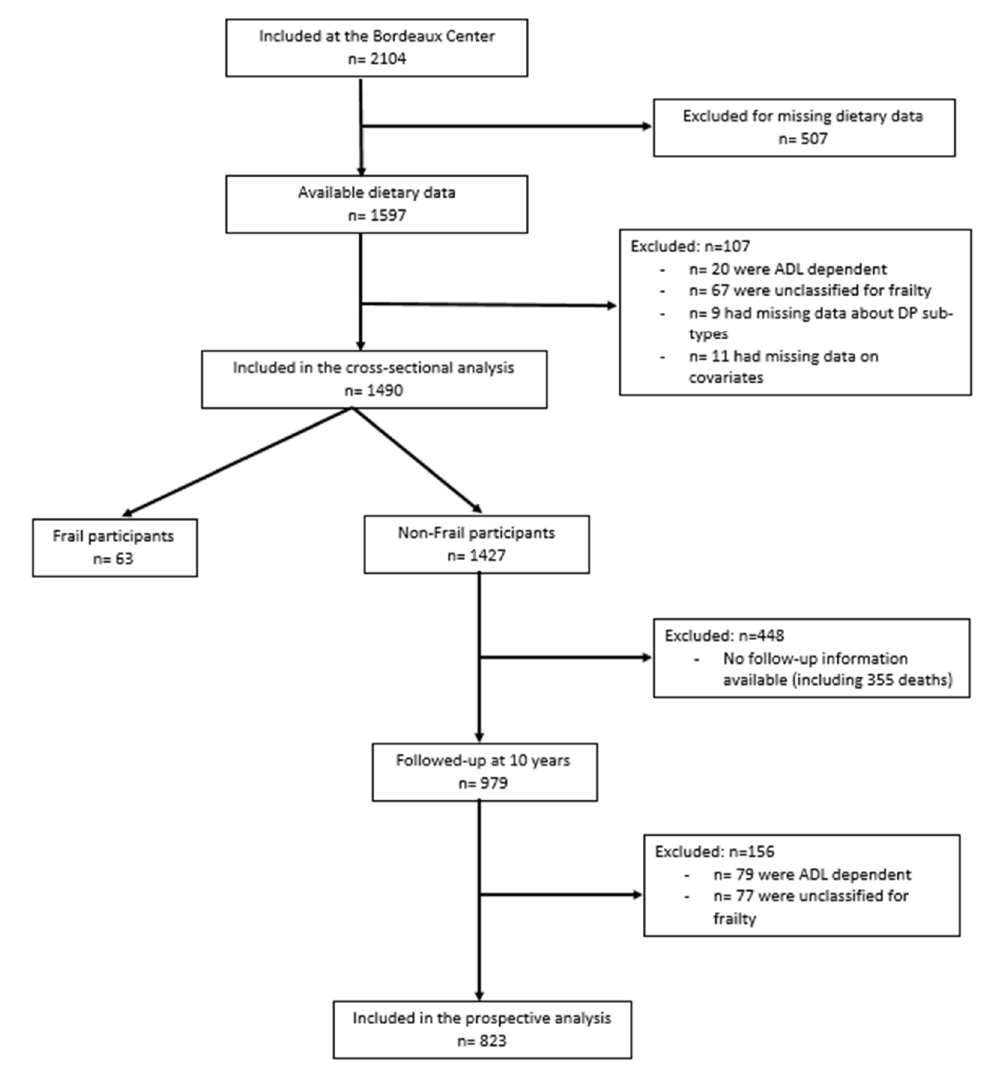
Figure 1. Flow chart of the cross-sectional and the prospective studied samples. Three-City Bordeaux Study, 2000–2010.